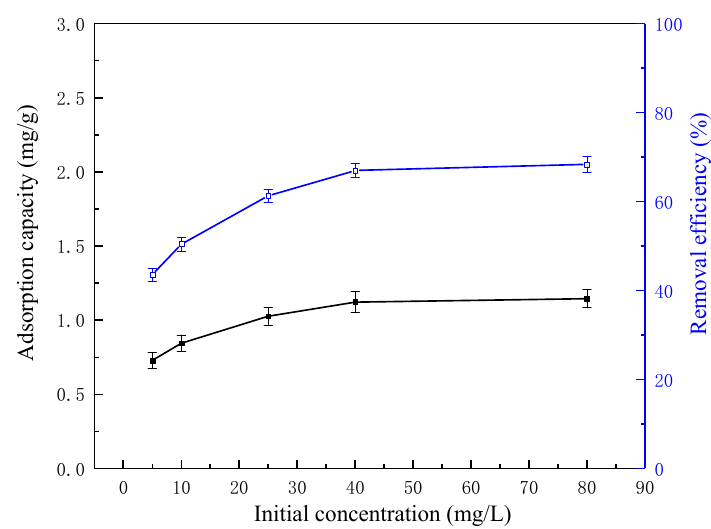
Figure 7. The e ff ect of the initial concentration on pyridine removal e ffi ciency and adsorption capacity Figure 7. The effect of the initial concentration on pyridine removal efficiency and adsorption capacity of pyridine. of pyridine.